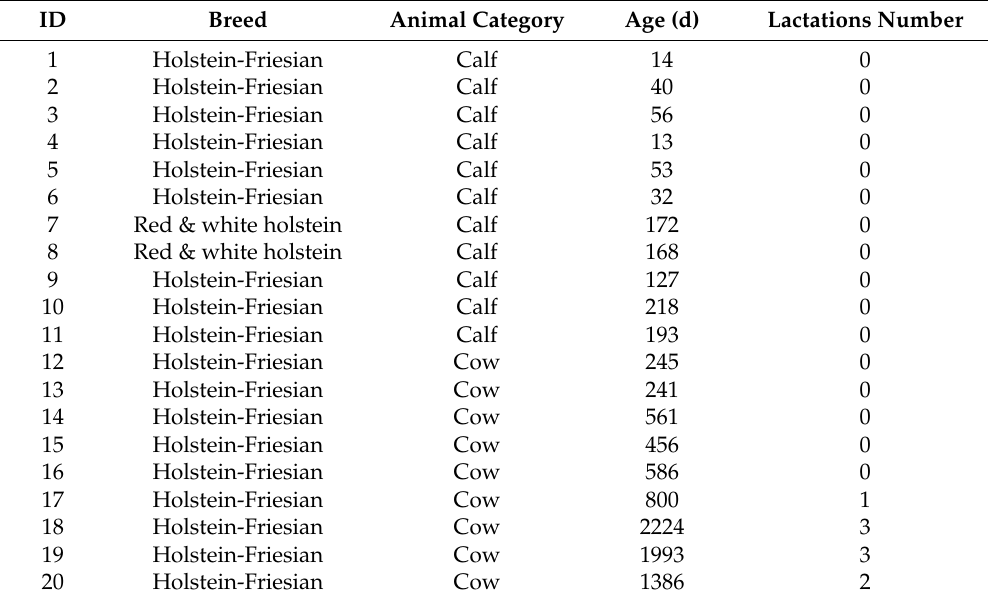
Table 3. Dairy cattles information .